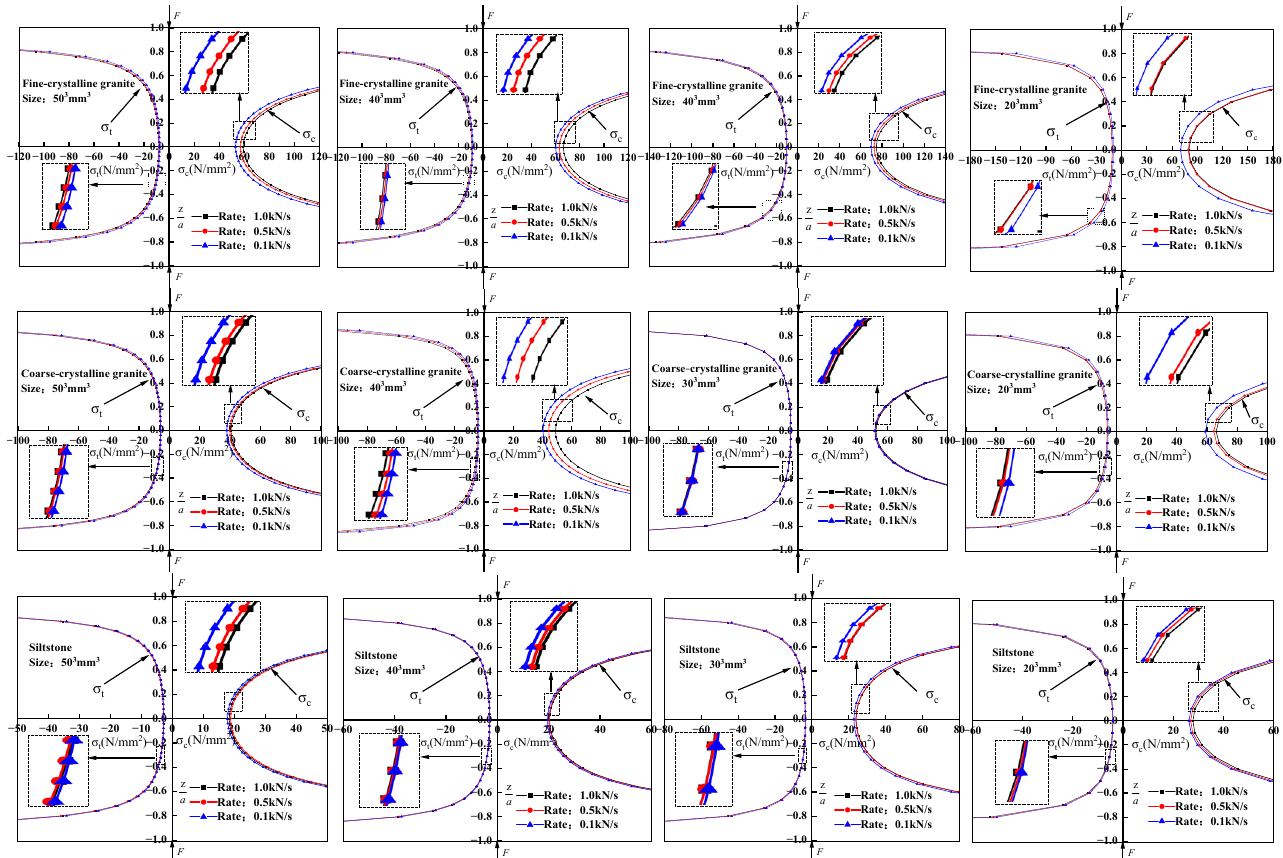
Poisson’s ratio μ of fine-crystalline granite, coarse-crystalline granite and silt- Poisson’s ratio µ of fine-crystalline granite, coarse-crystalline granite and siltstone stone were 0.200, 0.185, and 0.180, respectively, as measured by an indoor uni- were 0.200, 0.185, and 0.180, respectively, as measured by an indoor uniaxial compression axial compression test, and the distribution of tensile and compressive stresses test, and the distribution of tensile and compressive stresses on the loading axis of the on the loading axis of the rock sample point load could be analyzed by substi- rock sample point load could be analyzed by substituting Equations (1) and (2). The stress tuting Equations (1) and (2). The stress distribution states of three rock samples distribution states of three rock samples of different sizes under different loading rates of different sizes under different loading rates were plotted, with the vertical were plotted, with the vertical axis coordinate scale being the ratio of the coordinate z of the axis coordinate scale being the ratio of the coordinate z of the corresponding corresponding point to the height a of the rock sample, and the horizontal axis coordinate point to the height a of the rock sample, and the horizontal axis coordinate scale scale being F /(2 π a 2 ). The plotted results are shown in Figure 6. being F /(2 π a 2 ). The plotted results are shown in Figure 6.